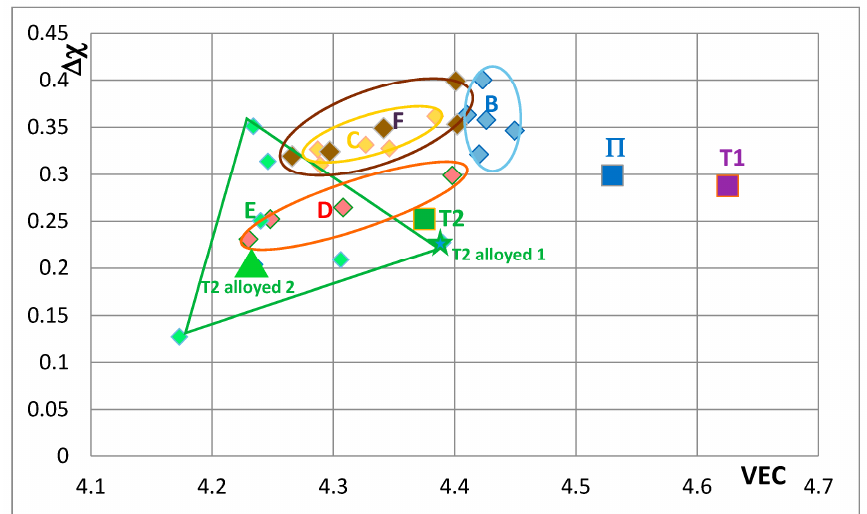
Figure 8. Δχ versus VEC map of unalloyed and alloyed Nb 5 Si 3 that shows the effect of the substitution of Nb by Hf (and Ti and Cr), where T1 = Nb 5 Si 3 , Π = (Nb,Ti) 5 Si 3 , T2 = Nb 5 (Si,B) 3 , area B = (Nb,Ti,Cr) 5 (Si,Al) 3 , area C = (Nb,Ti,Cr,Hf) 5 (Si,Al,Ge) 3 , area D = (Nb,Ti,Cr,Hf) 5 (Si,Al,Sn) 3 , area E = (Nb,Ti,Cr,Hf) 5 (Si,Al,B) 3 and area F = (Nb,Ti,Cr,Hf) 5 (Si,Al) 3 . The data is from KZ5 type alloys with nominal compositions Nb-24Ti-18Si-5Al-5Cr + 5Hf + 5X, where X = B, Ge, Sn. Average positions in areas B to F are indicated by data point closest to letter (see text). For compositions of Π , T2 and T2 alloyed1 andT2 alloyed2 see text.